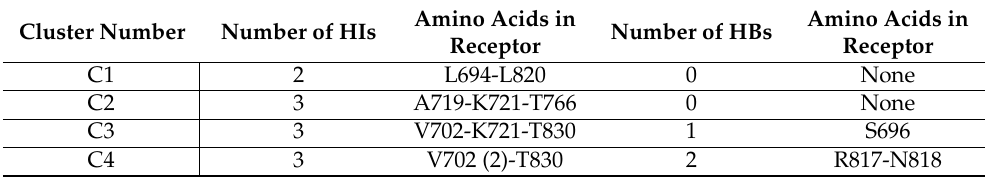
Table 1. The detected interactions from the PLIP webserver.